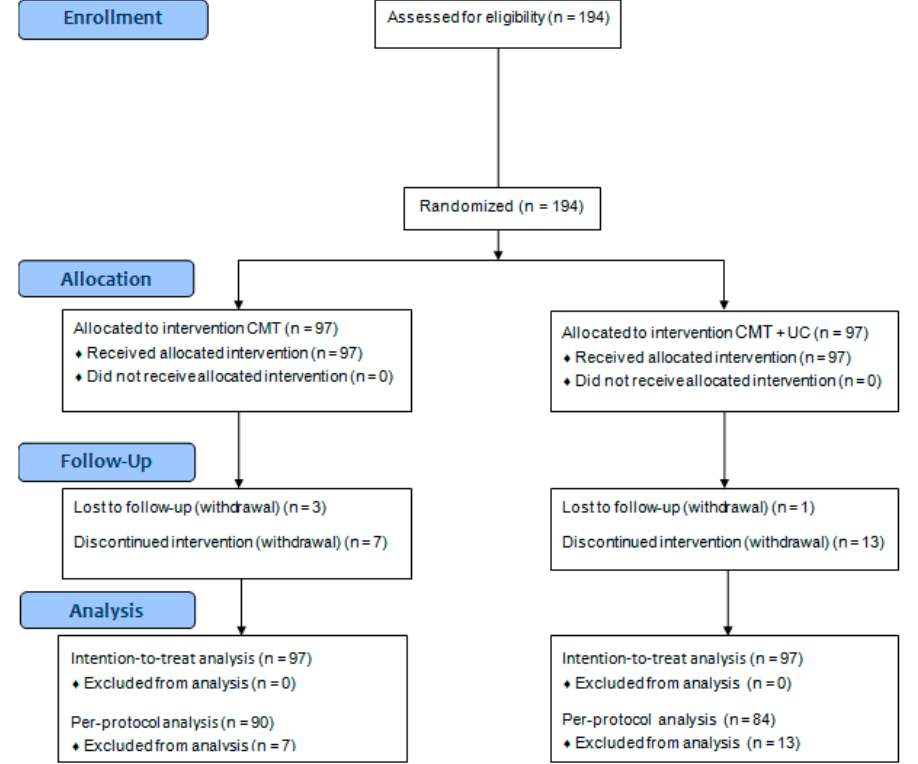
Figure 2. Consolidated Standards of Reporting Trials (CONSORT) 2010 flow diagram. CMT: Chuna manipulative therapy; UC: usual care. Table 1. Descriptive statistics of demographic and health status variables at baseline (1 week)